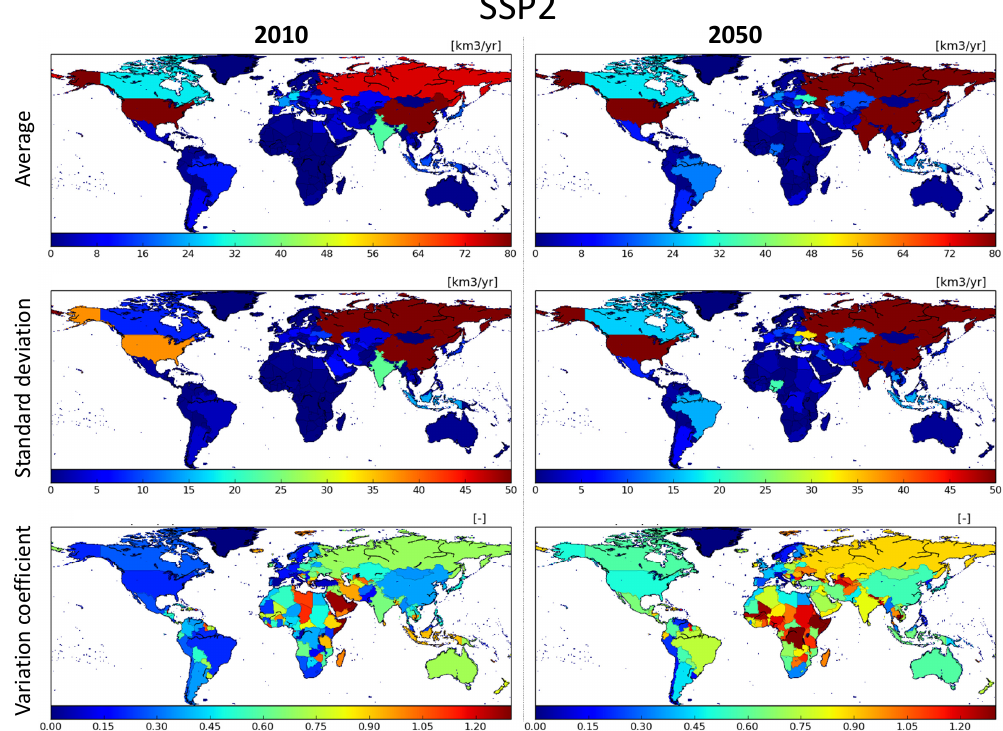
Figure 7. Global maps of projected industrial water withdrawals calculated by the global water models H08, PCR-GLOBWB, and WaterGAP for the years 2010 and 2050, respectively, under the SSP2 scenario. Avr, Std, and Std/Avr denote average, standard deviation, and coefficient of